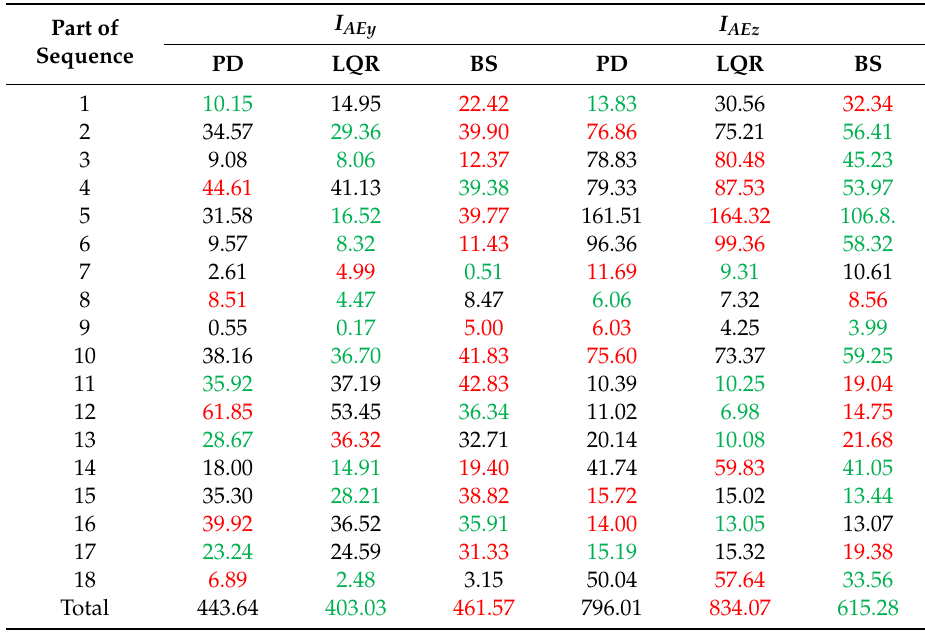
Table A3. Quality indicators of controllers’ performance: Integral of the vector part of absolute